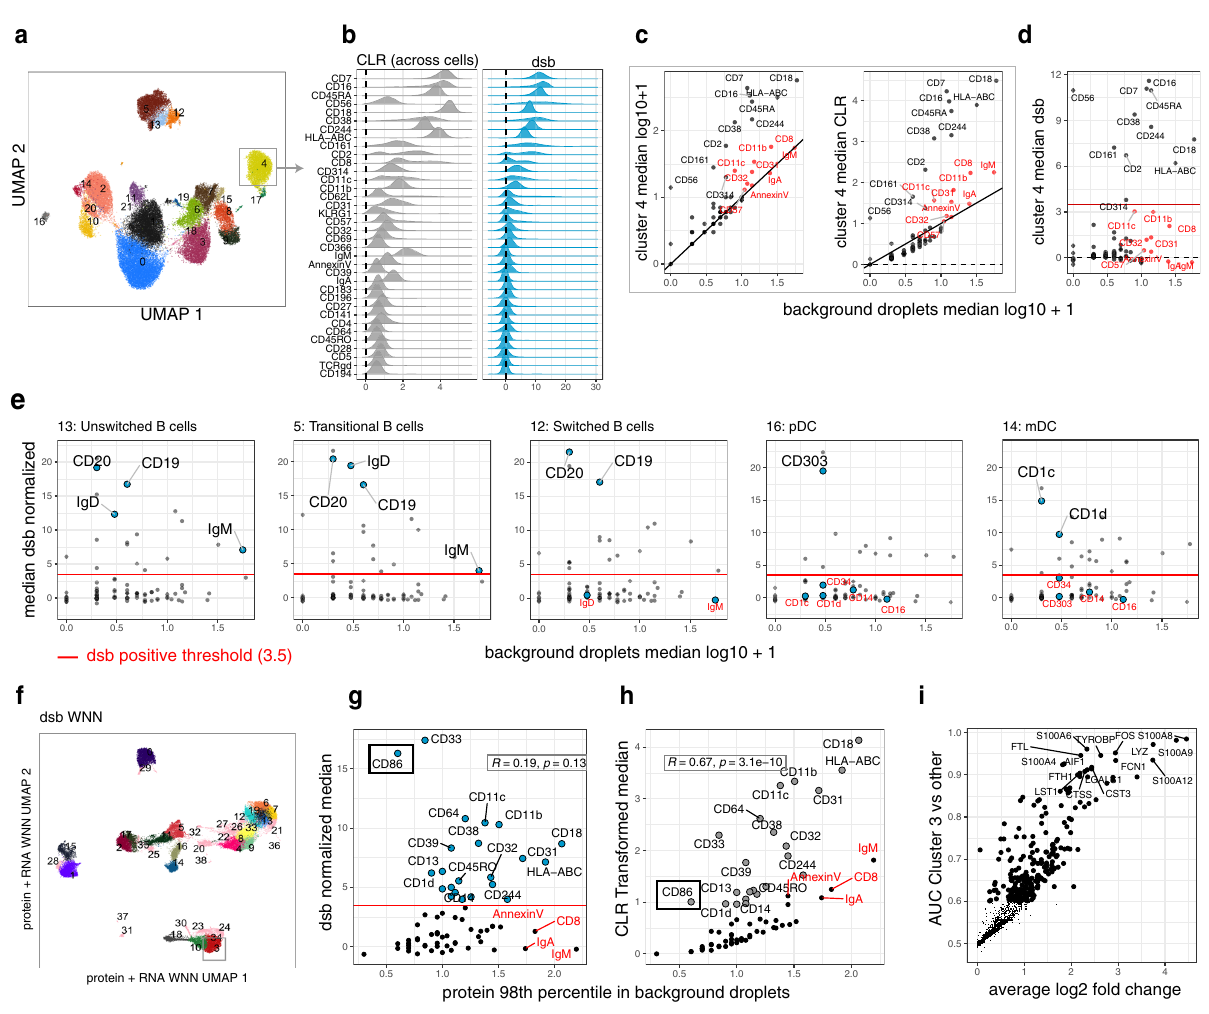
Fig. 3 Case study I: dsb improves interpretation of cell clusters derived from protein-based and joint mRNA – protein clustering. a UMAP plot of single cells labeled by cluster number (clustering was performed using dsb normalized protein values). b The distribution of protein expression of cluster 4 (highlighted with a gray box in ( a )) using CLR (across cells) or dsb for normalization. c Median log + 1 protein levels (left) and CLR transformed across cells (as in ( b ), right) in cells from cluster 4 versus the level in empty droplets; proteins highlighted in red are comparable in expression to “ positive ” proteins after log transformation (left) and CLR transformation across cells (right) but are similar to background levels in empty droplets (identity line y = x shown in black). All proteins with median log10 expression >1 but <3.5 after dsb normalization are labeled with the protein name. d Similar to (c), but the y - axis shows the median dsb normalized values; proteins in red (those near the diagonal in ( c )) are now residing below our uniformly applied dsb positivity threshold of 3.5, re fl ective their proximity with mean counts in empty droplets; proteins above the red line have median dsb normalized expression within the highlighted cluster 4 (see ( a ) and ( b )) above 3.5, i.e., 3.5 standard deviations above ambient noise, ±adjustment for the cell intrinsic technical component. e The dsb normalized value vs. the median value in empty droplets of proteins within a subset of protein-de fi ned clusters. A subset of proteins informative for cluster identi fi cation from B cell and dendritic cell subsets with a dsb value above 3.5 (red line) are annotated with the protein name within each panel and are labeled in red when below 3.5 within each subset. Proteins labeled for B cell subsets (C13: Unswitched B cells, C5 Transitional B cells, C12 Switched B cells) include B cell proteins CD20, CD19, IgD, and IgM, proteins labeled for the dendritic cell subsets (C16: pDC, C14: mDC) include innate cell markers CD1c, CD1d, CD34, CD14, CD16, and CD303. f UMAP plot of the same cells shown in ( a ) but the UMAP embeddings and clusters here were derived using Seurat ’ s weighted nearest neighbor (WNN) mRNA-protein multimodal algorithm applied to dsb normalized values. g Similar to ( d ) but derived using cells from WNN cluster 3; Pearson correlation coef fi cient and p value (two sided) are shown between median dsb normalized values and the 98th percentile expression value (log10) of the same protein in empty droplets. h Similar to ( g ) but for CLR normalized values. i . Differentially expressed genes (ROC test; see the “ Methods ” section) for cell in cluster 3 vs. other